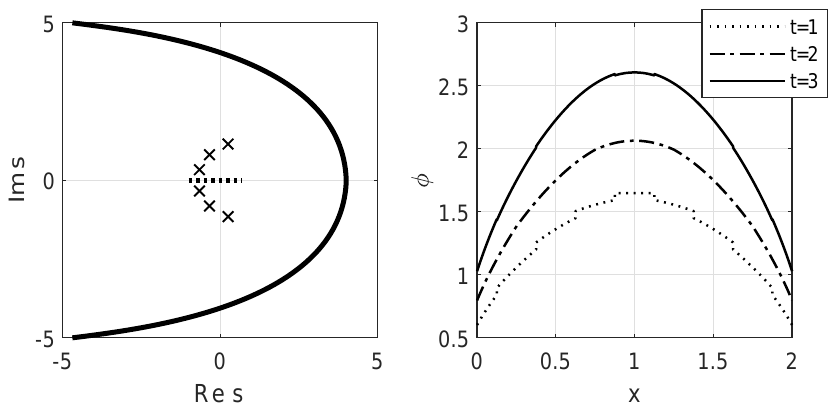
Figure 1: (Left) Contour used in example calculation. Repeated roots are denoted with an × and the branch cut with a dotted line. (Right) Scalar flux at different